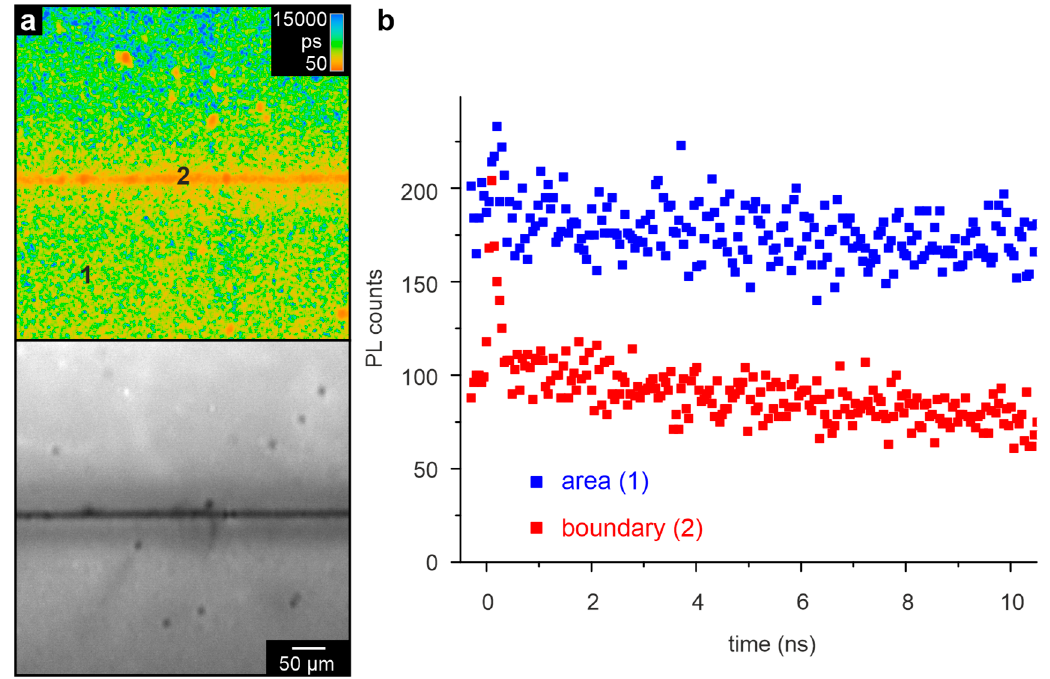
Figure 12. FLIM analysis of the 36.8° bicrystal after thermal reduction. ( a ) Photoluminescence lifetime and intensity maps; ( b ) decay traces for two selected spots.